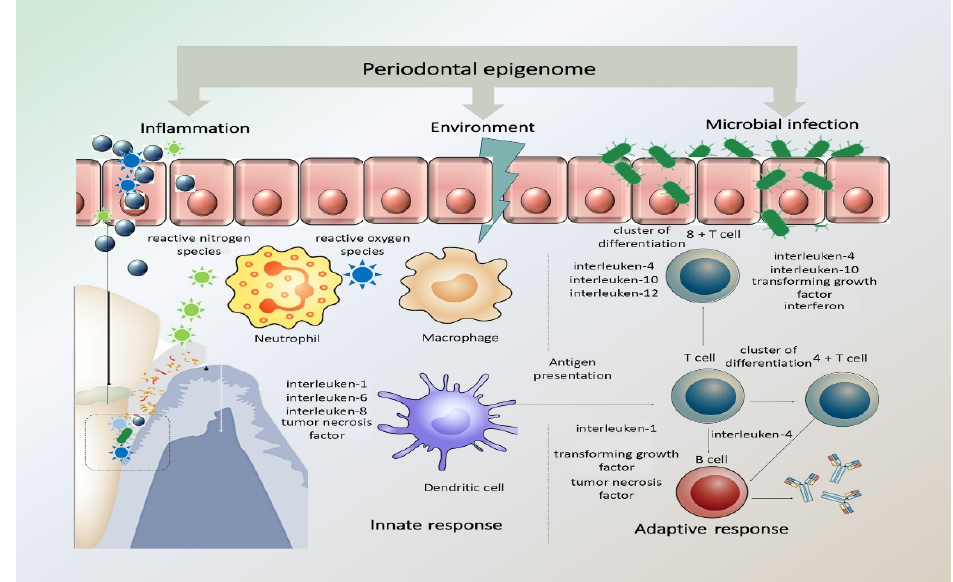
Figure 1. Periodontal epigenome in response to microbial infection, environmental stimuli, and inflammation. The periodontal inflammatory response has both protective and destructive elements that pathogens may alter. The innate inflammatory response relies on the recognition of microbial pathogens and is mediated by neutrophils, tissue macrophages, subepithelial dendritic cells, natural killer cells, and monocytes. The activated immune cells produce and release reactive oxygen species (ROS) and reactive nitrogen species (RNS) in response to infection. This acute inflammatory response turns to a chronic stage when the antigen-presenting cells become involved and present the antigens/microorganisms to immunocompetent cells expanding the antibody-secreting plasma cell population. (Adapted with permission from Wiley Publisher).